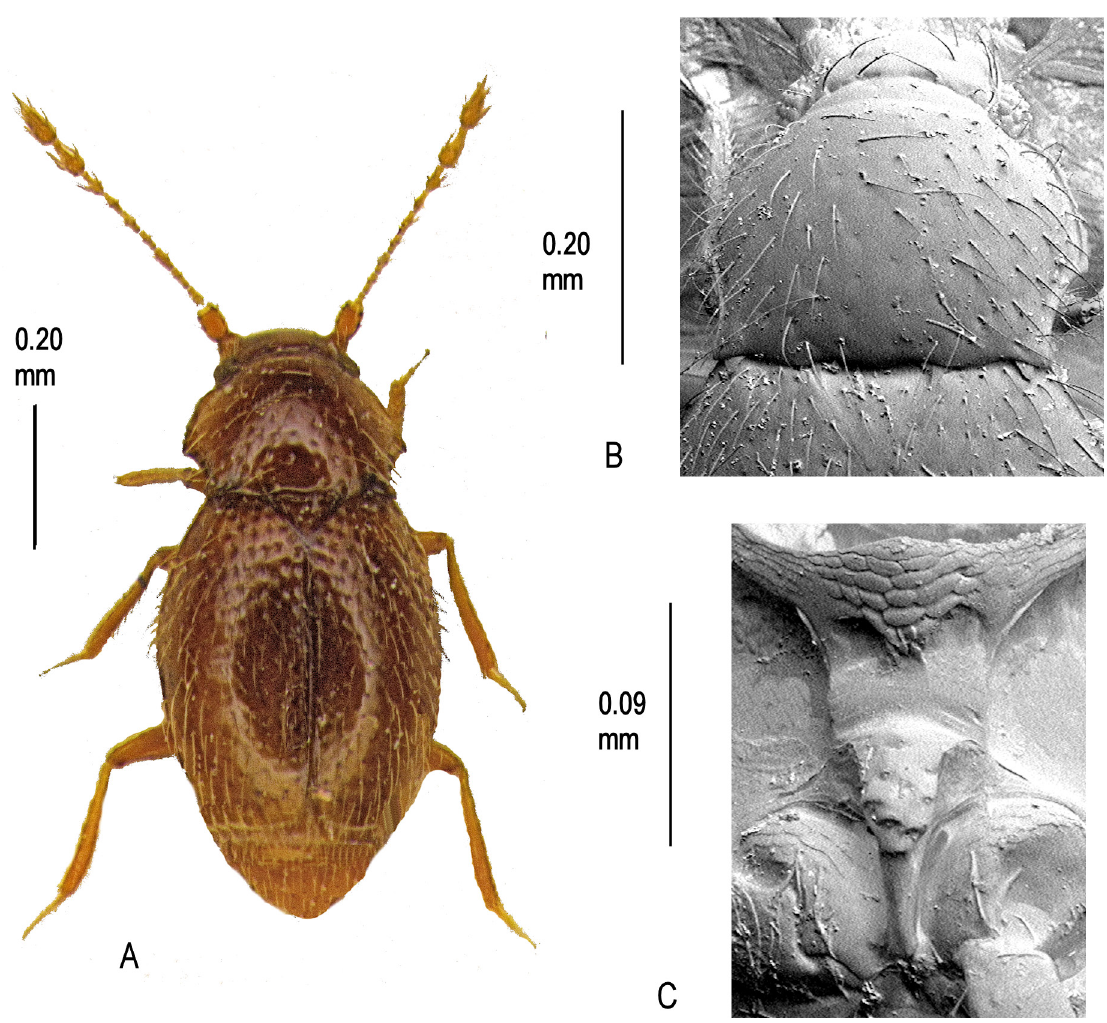
Fig. 101. Cissidium reitteri (Matthews, 1889). A . Habitus. B . Pronotum, × 330. C . Mesoventrite showing median process of collar, mid-keel and keel,